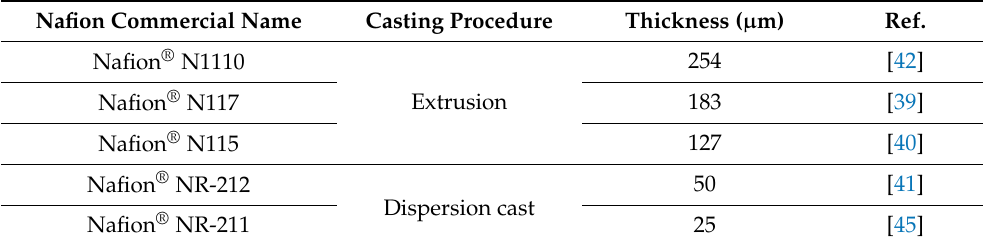
Table 2. Commercial Nafion membranes.